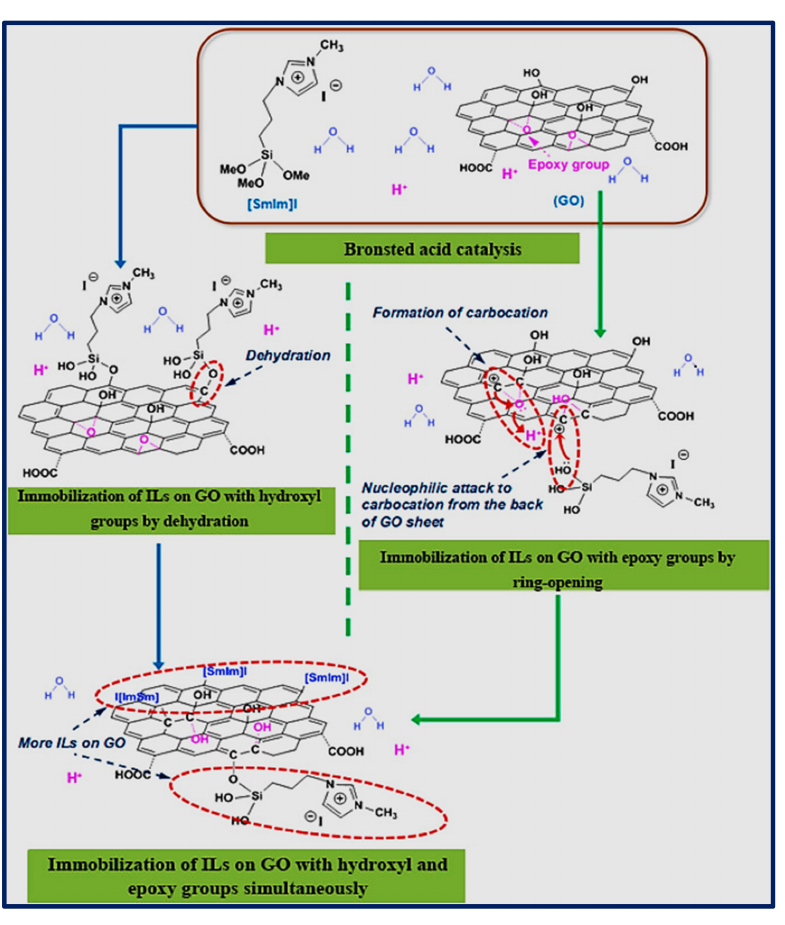
Figure 4. The mechanism for ILs immobilization on GO sheets in the acid medium. Reprinted with permission from Ref. [69]. Copyright 2018, Elsevier.